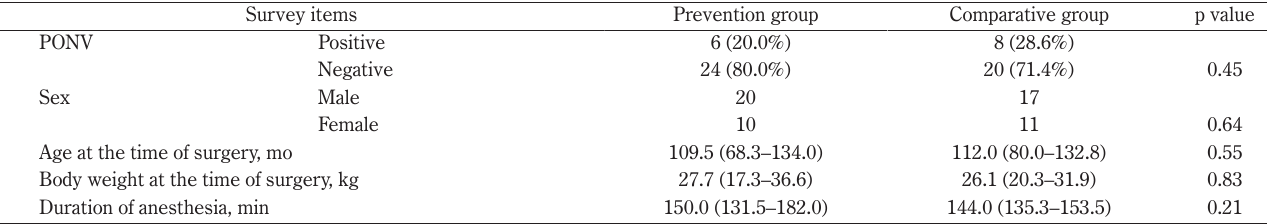
Table 1 Comparison of survey items between the prevention and comparative